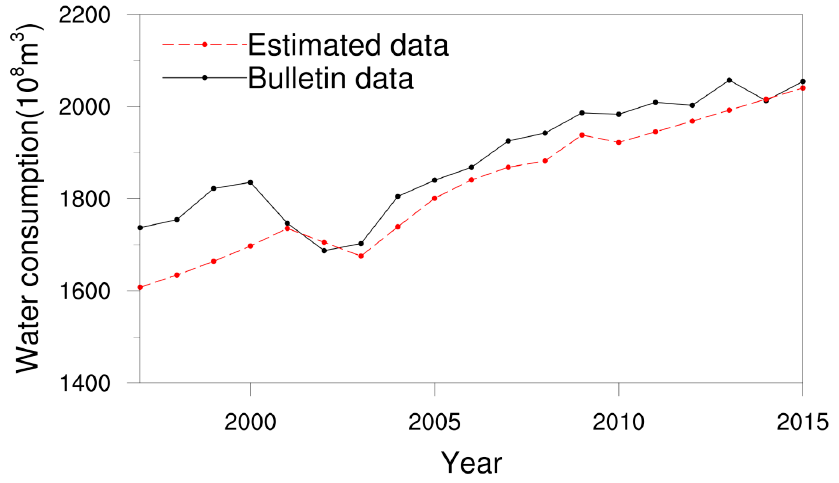
Figure 4. Validation of water consumption data in the Yangtze River Basin.